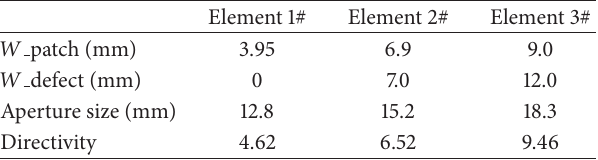
Figure 5: Pairwise mirrored element array. Table 2: Design parameters of simple defect substrate patch antenna.